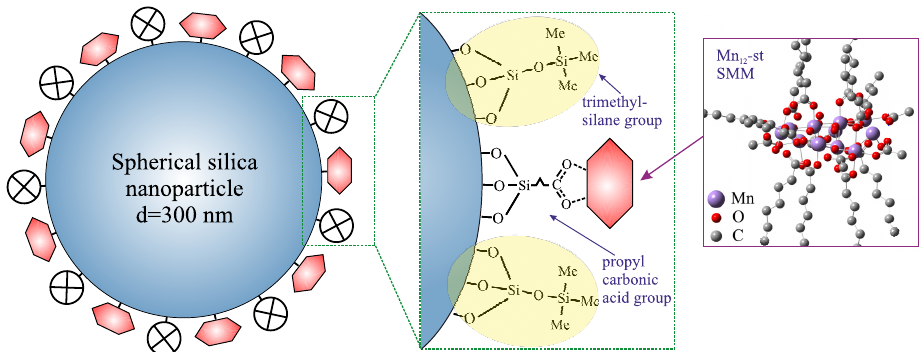
Figure 1. Schematic representation of the investigated material—spherical silica nanoparticles containing deposited Mn 12 -st SMMs with controlled distance between molecules. Trimethyl silane units play the role of spacers/separators between SMMs, maintaining the assumed distances between them. The number of spacers per single magnetic molecules determines the distribution of Mn 12 -st at the silica’s